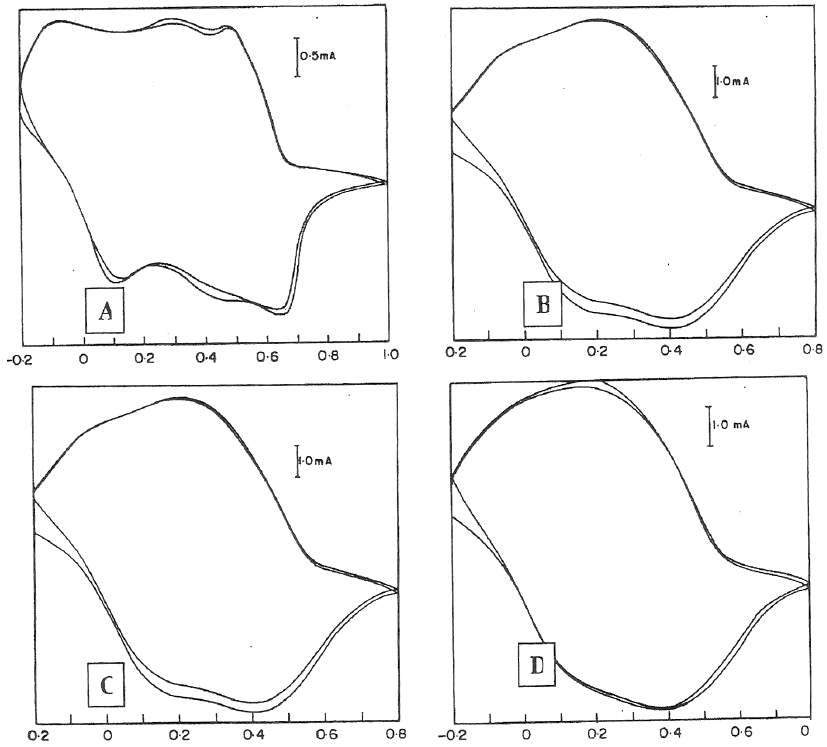
Figure 5. Cyclic voltammogram of (A) pure polyaniline, (B) poly( o -toluidine)-clay nanocomposite, (C) poly( o -anisidine)-clay nanocomposite and (D)